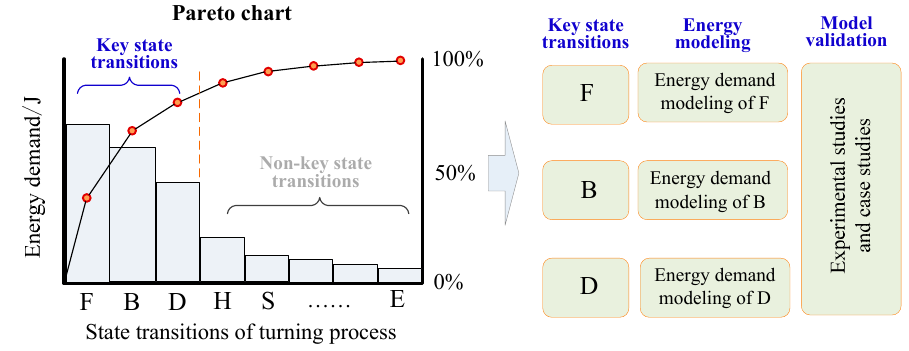
Figure 2. Framework of the proposed methodology.